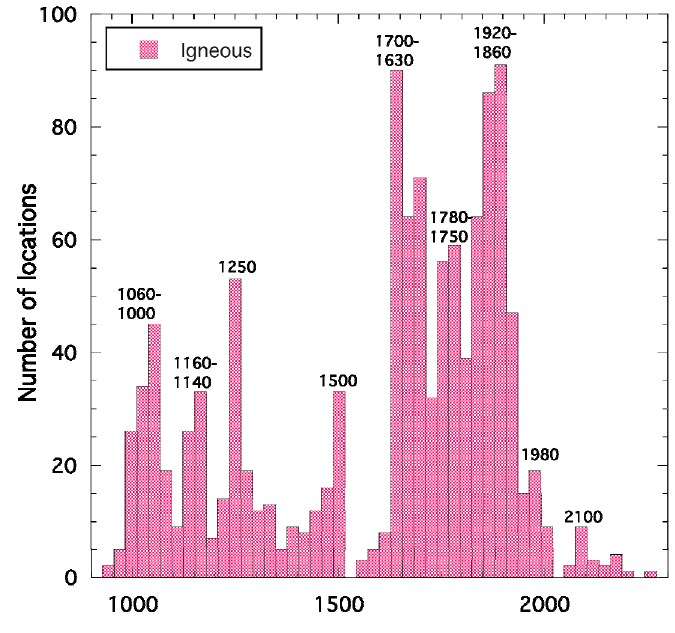
Figure 16. Frequency of zircon ages from igneous rocks preserved in the Laurentian